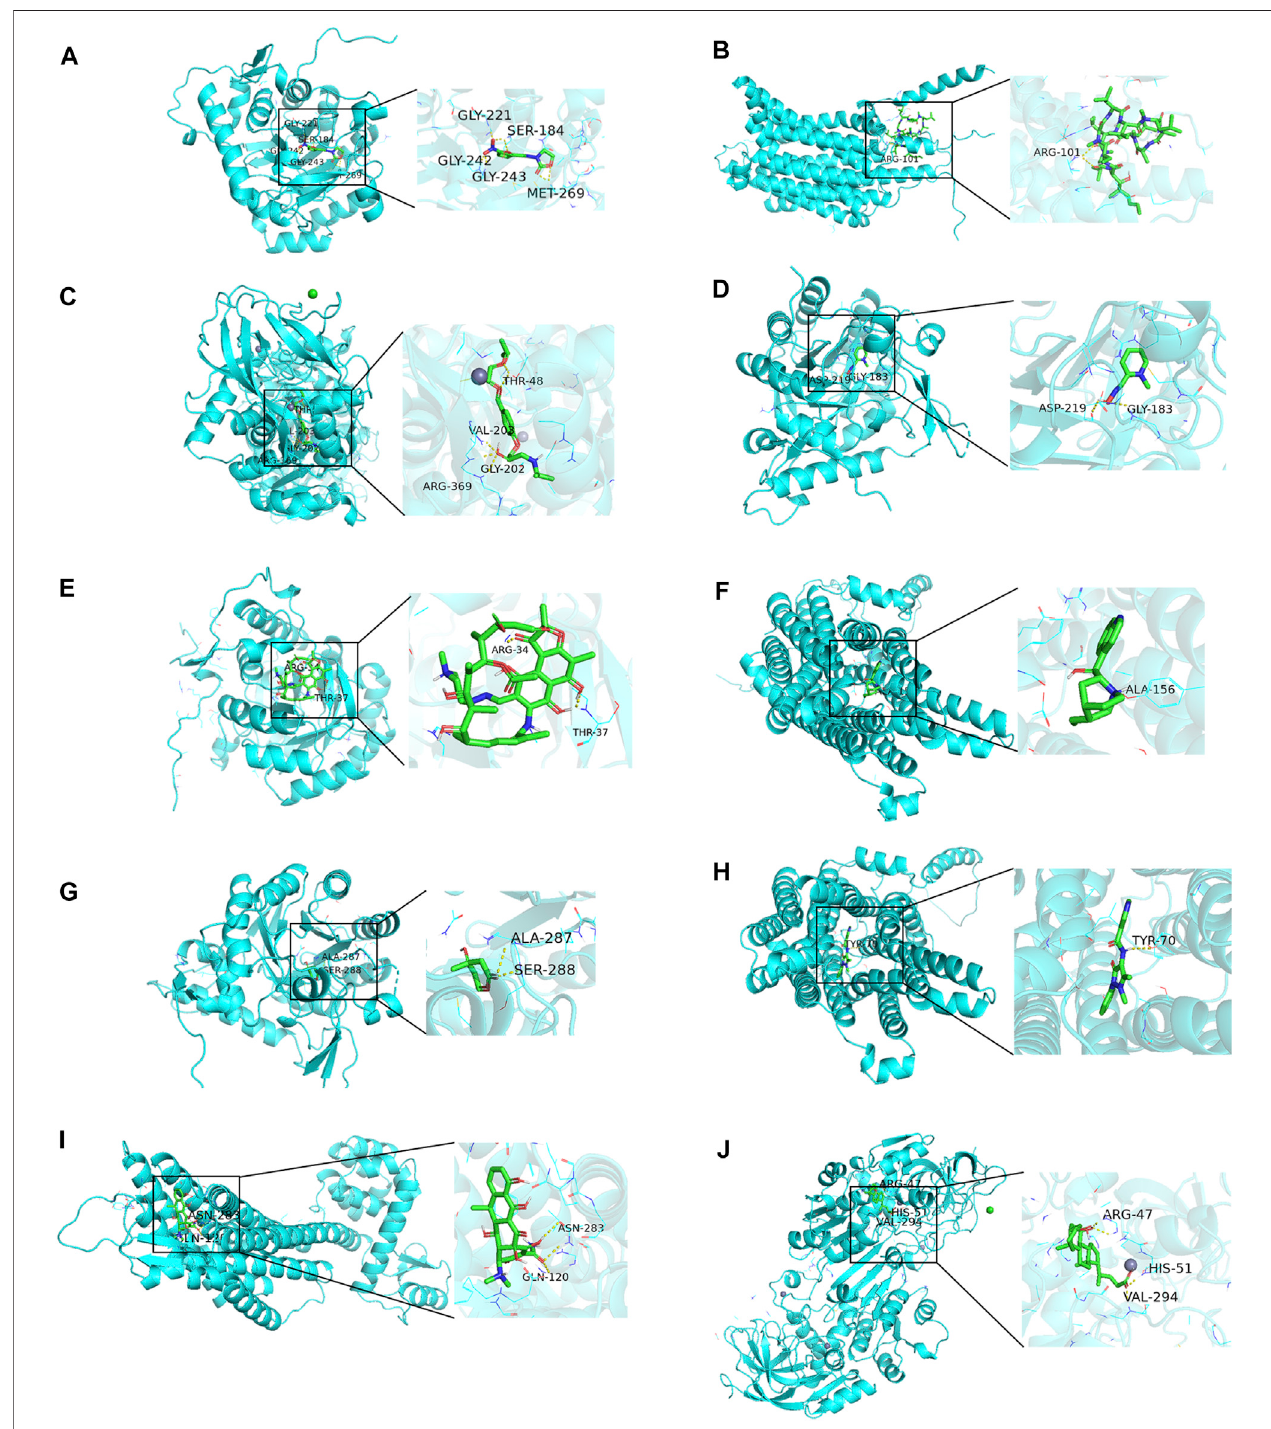
FIGURE 12 | Docking diagram of small molecule drugs with targets. (A) Furazolidone-GMPR (B) Ciclosporin-SLC45A2 (C) bisoprolol-ADH1B (D) rifampicin- GMPR (E) pralidoxime-NPY1R (F) cinchonine-NPY1R (G) mevalolactone-GMPR (H) nifenazone-SLC45A2 (I) doxycycline-NPY1R (J) chenodeoxycholic acid-ADH1B.